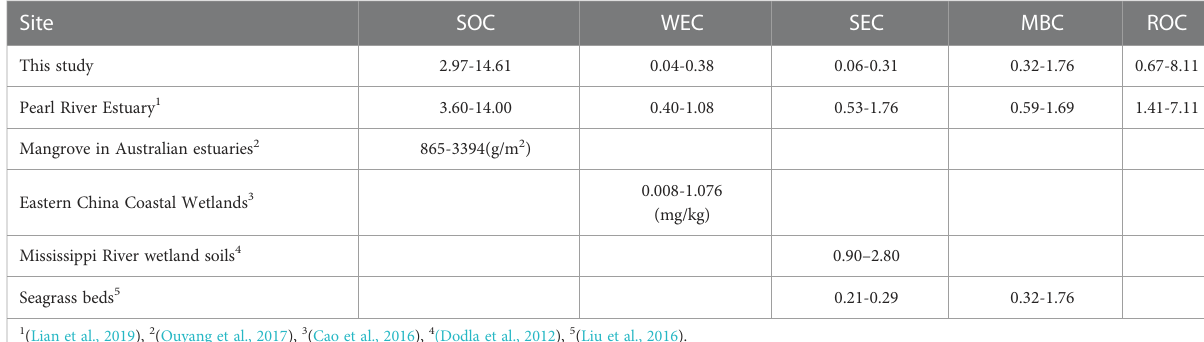
TABLE 2 The sedimentary carbon content and comparison with other sites (g/kg).